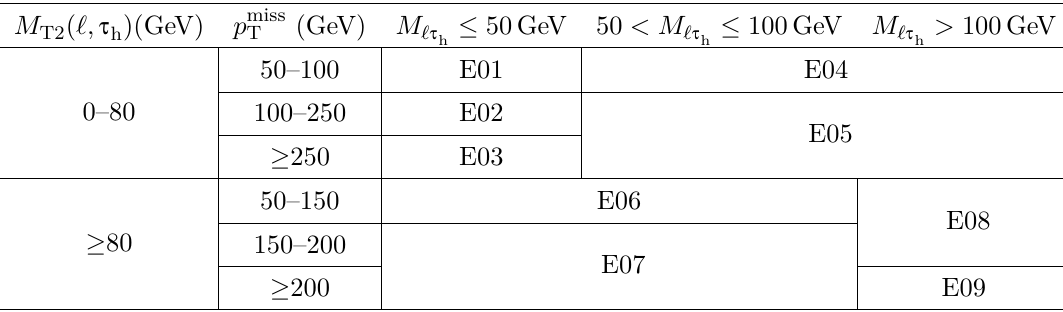
Table 8 . Definition of the search regions for events with a pair of light leptons of the same sign and a t candidate (EXX). h